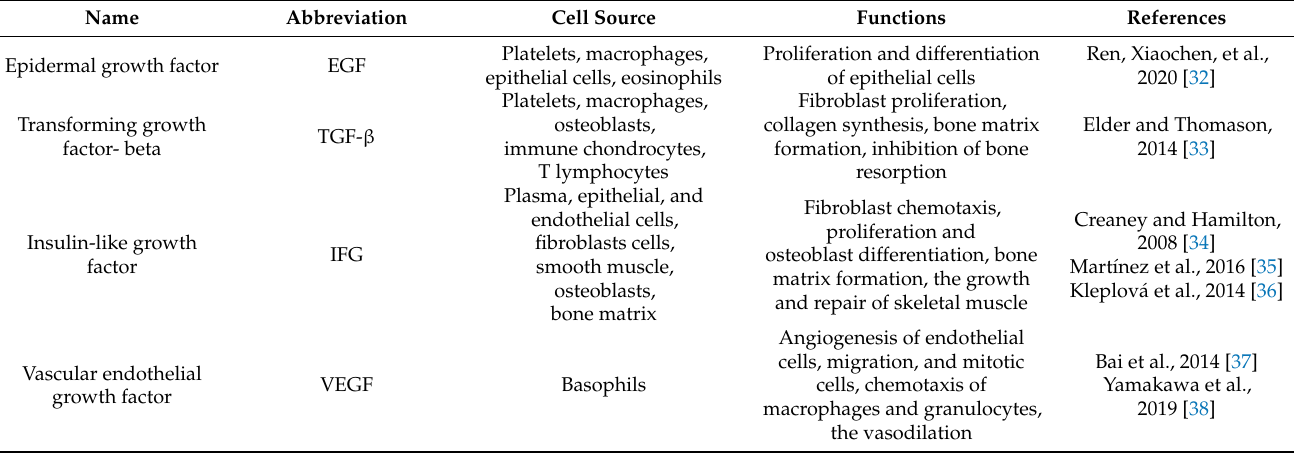
Table 1. Effect of growth factors present in